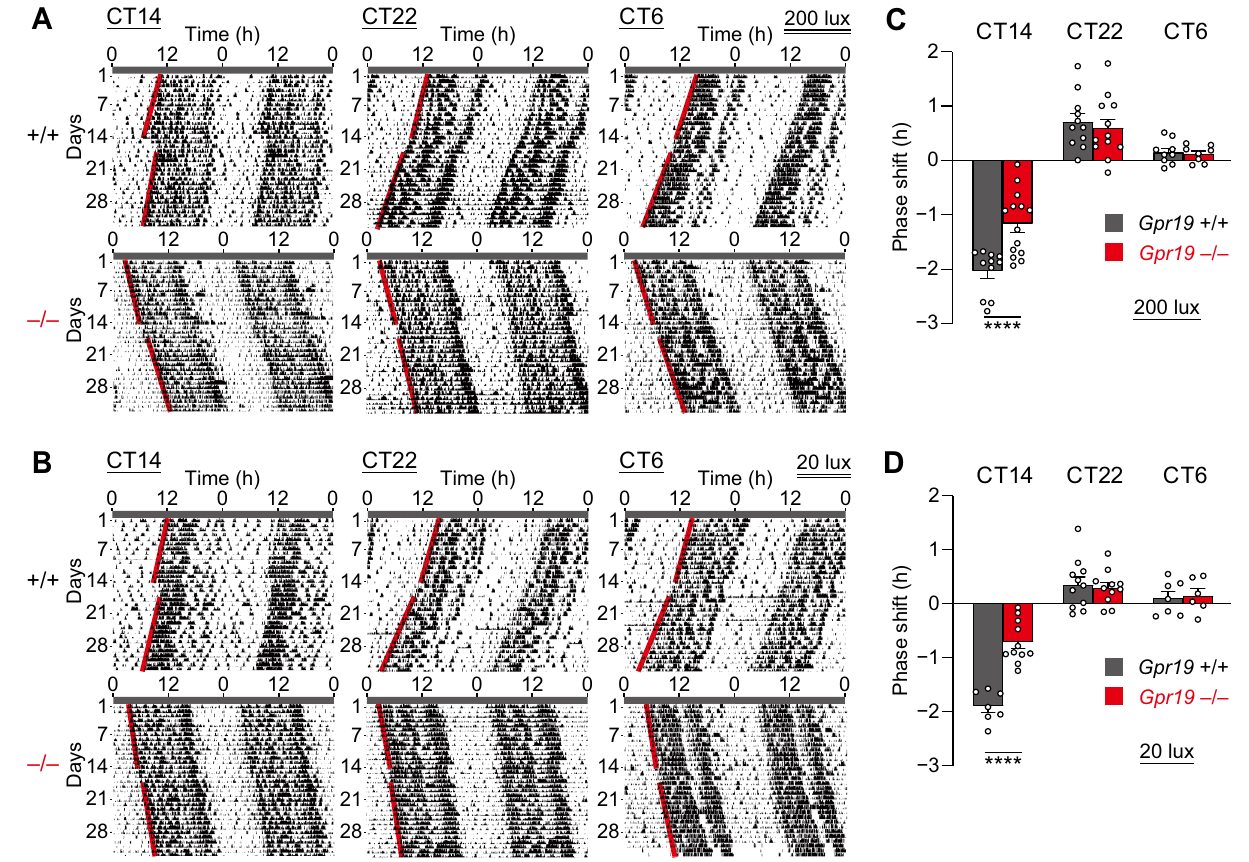
Figure 4. Gpr19 −/− mice exhibit a decreased capacity of phase shift to early subjective night light. ( A , B ) Representative double-plotted locomotor activity records of Gpr19 +/+ and Gpr19 –/– mice before and after a 15-min light pulse exposure at CT14, CT22, or CT6. CT was determined for individual animals based on their free-running period and the onset of locomotor activity (which is defined as CT12). The red lines delineate the phase of activity onset. Phase shifts (delay at CT14, advance at CT22) were quantified as the time difference between regression lines of activity onset before and after the light pulse, 200 lx for ( A ) and 20 lx for ( B ). ( C , D ) Magnitude of light-induced phase-shifts of Gpr19 +/+ and Gpr19 –/– mice. By convention, delays are negative, and advances are positive. Data indicate the mean ± SEM for 200 lx ( C ) and 20 lx ( D ) (200 lx: CT14, Gpr19 +/+ n = 11, Gpr19 −/− n = 14; CT22, Gpr19 +/+ n = 11, Gpr19 −/− n = 12; CT6, Gpr19 +/+ n = 9, Gpr19 −/− n = 8; 20 lx: CT14, Gpr19 +/+ n = 7, Gpr19 −/− n = 11; CT22, Gpr19 +/+ n = 11, Gpr19 −/− n = 11; CT6, Gpr19 +/+ n = 7, Gpr19 −/− n = 6). **** P < 0.0001, two-way ANOVA with Bonferroni’s post hoc